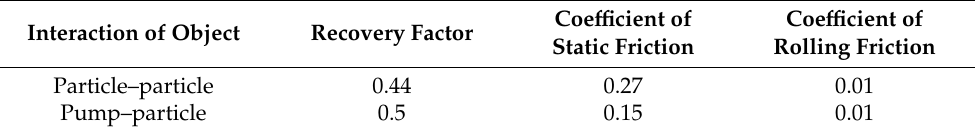
Table 3. Solid interaction parameters.